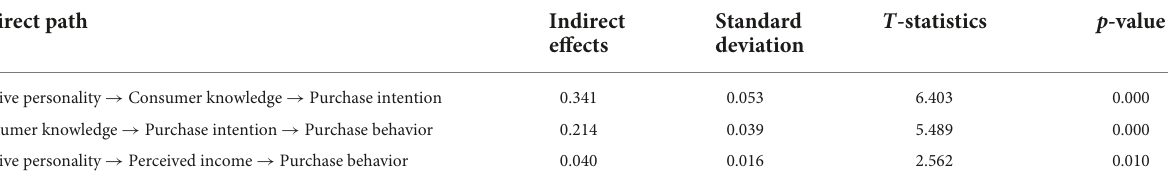
TABLE 5 Mediating